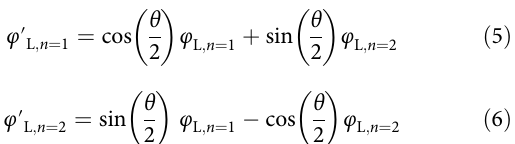
ð t Þ (left) and φ ð e Þ ð t Þ (middle) and φ ð e Þ ð t Þ (right). The 1 2 3 ð t Þj 2 and energy j φ ð e Þ ð ω Þj 2 distributions obtained by integration of W ð t ; ω Þ over ω and t . j φ ð e Þ ð ω Þj 2 is φ ð e Þ i i 1 i